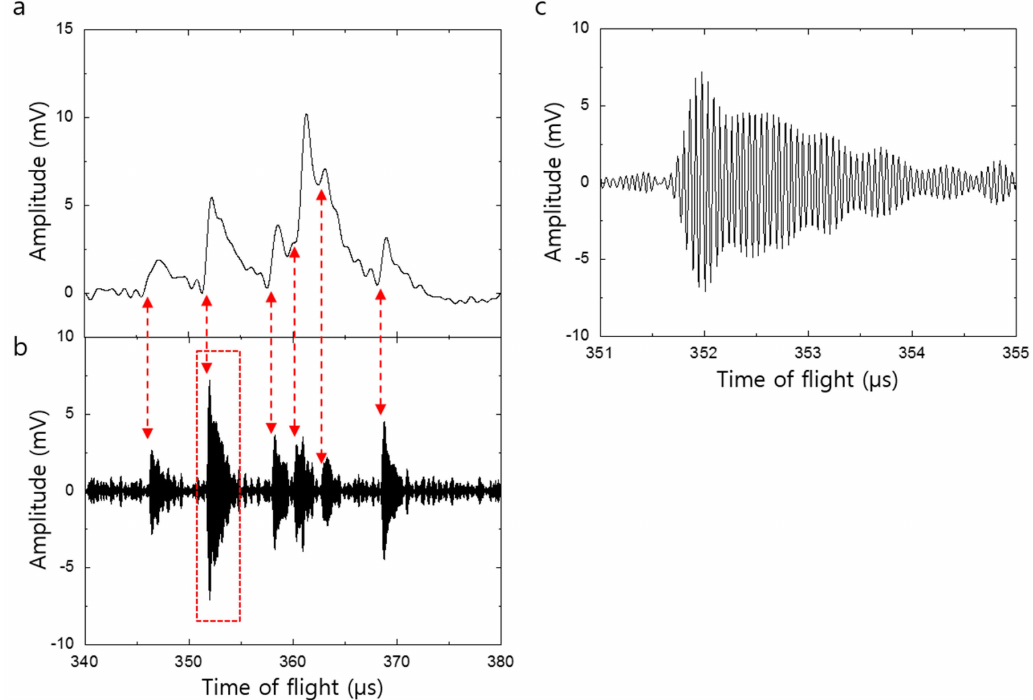
Figure 4. ( a ) Low frequency decomposition of Figure 2a, showing phonon-assisted field emission; ( b ) High frequency decomposition of Figure 2a, showing the mechanical vibration of the nanomembrane. The onset times of the mechanical oscillations coincide with the time-of-flight of the leading edge of the ion packet; ( c ) Magnified view of the peak enclosed by dashed lines in ( b ), clearly showing mechanical